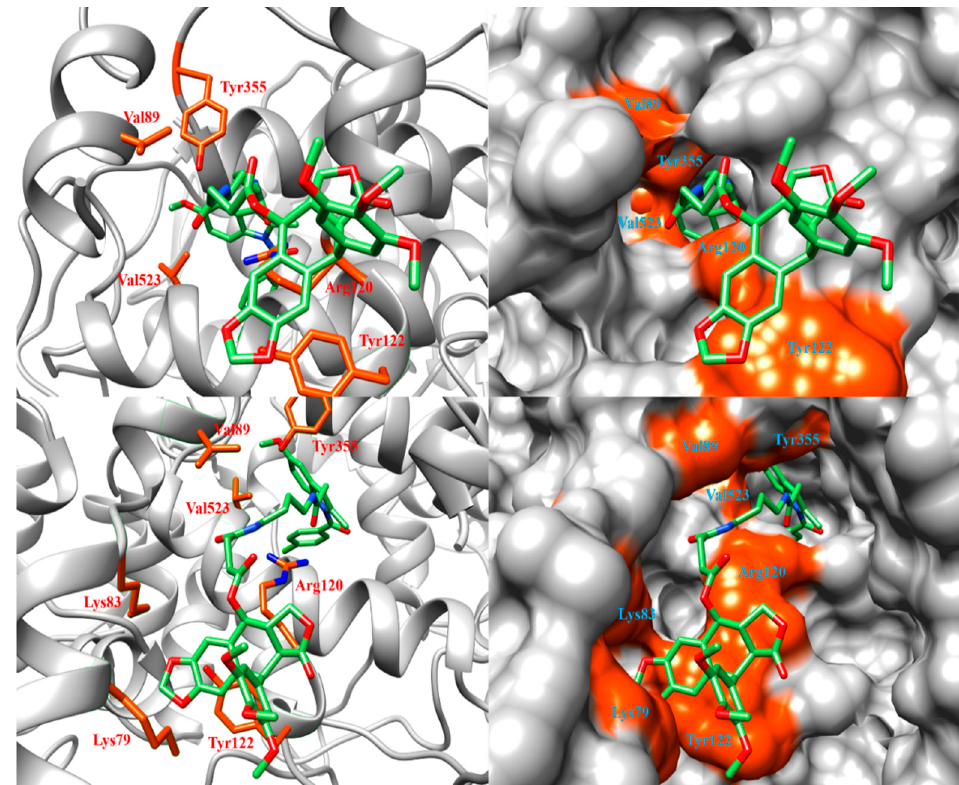
Figure 4. Binding pose between chemocoxib A and COX-2 (PDB ID: 4OTJ). The orange-colored surface represents the residues at the gate of COX activity. Since the binding pose was hidden by COX-2 residues, the upper figure is represented by removing residues from Thr71 to Lys83, and the lower figure was represented by removing residues from Tyr115 to Ser119.